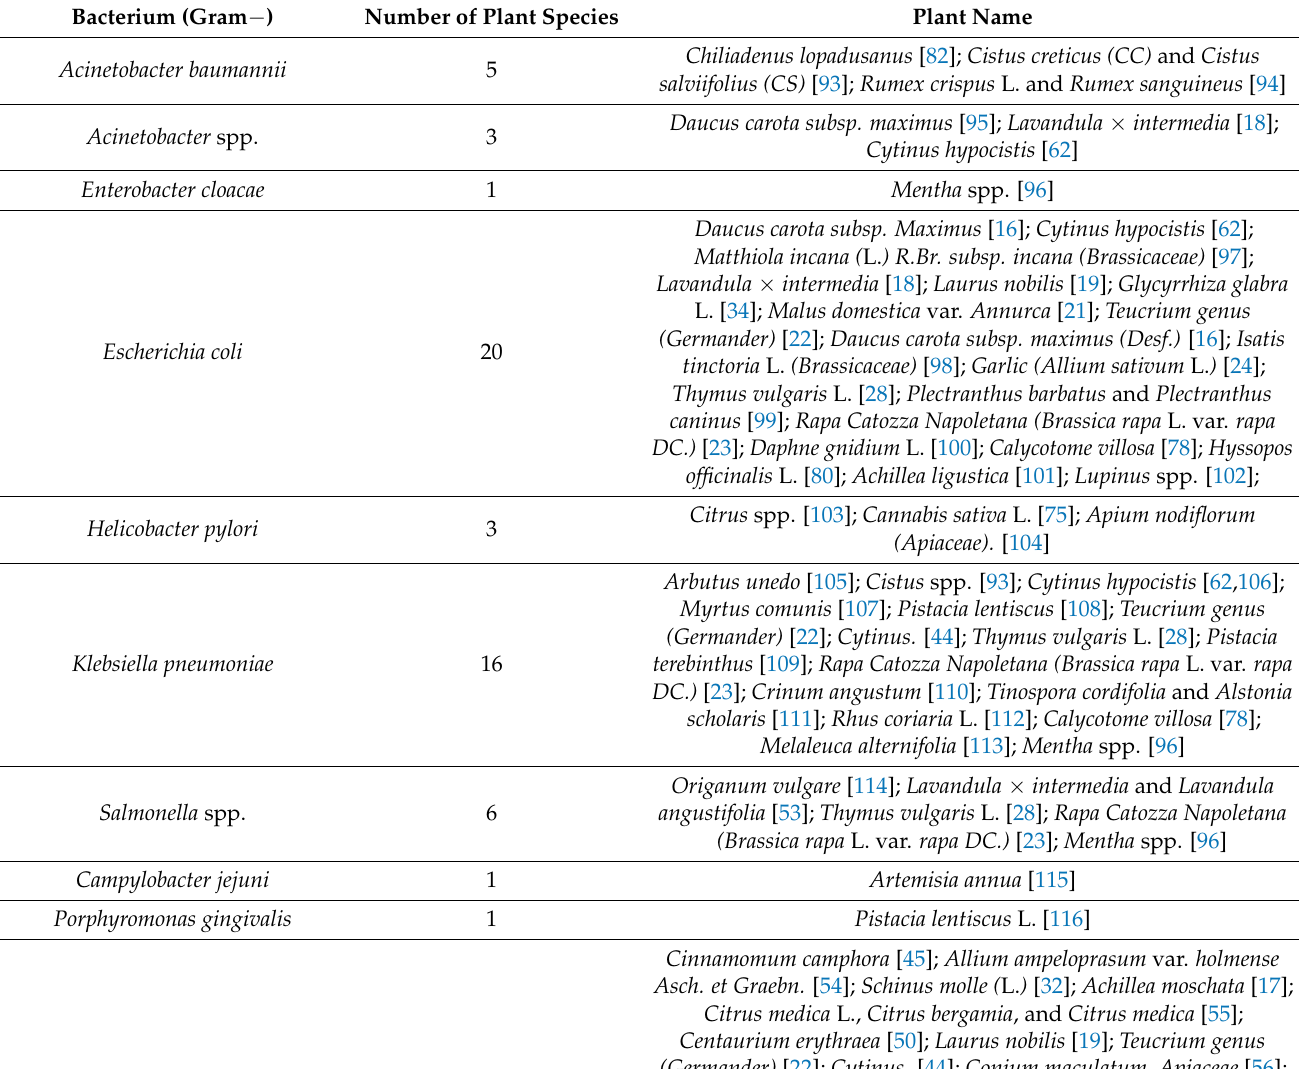
Table 2. Plants active against Gram −